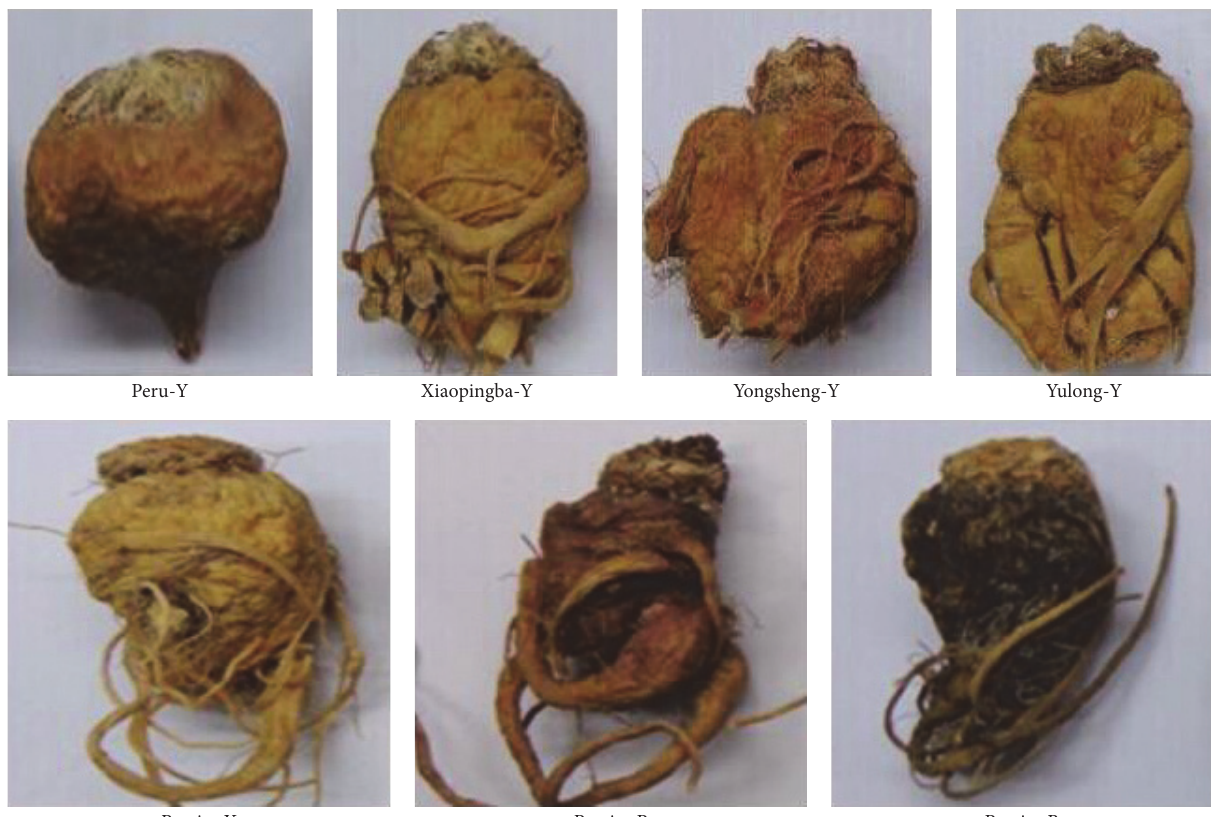
Figure 1: Photographs of 7 maca